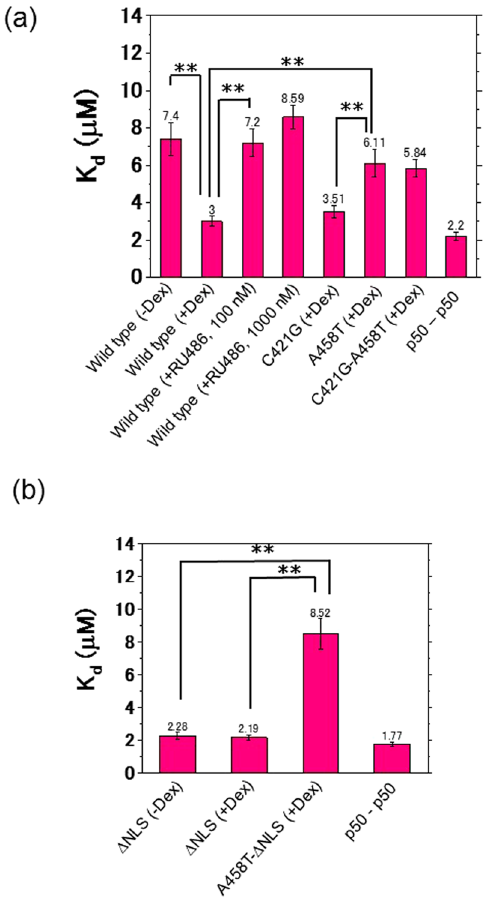
Figure 7. A summary of the dissociation constants (K d ) of the WT and mutants before and after addition of ligands. The bars indicate the dissociation constants, K d . ( a ) Before addition of Dex, the dissociation constant (K d ) of the WT was 7.40 μ M in the cytoplasm, and after addition of Dex the K d values of the WT, C421G, A458T, and C421G-A458T were 3.00, 3.51, 6.11, and 5.84 μ M, respectively, in the nucleus. K d of the control p50- p50 in the nucleus was 2.20 μ M. ( b ) Before addition of Dex, K d of ∆ NLS was 2.28 μ M and after addition of Dex, K d values of the ∆ NLS and A458T- ∆ NLS mutants in the cytoplasm were 2.19 and 8.52 μ M, respectively. K d of the p50-p50 dimer in the cytoplasm was 1.77 μ M. The data are presented as mean ± SD. Statistical analysis was based on ANOVA ( * p < 0.05, ** p <